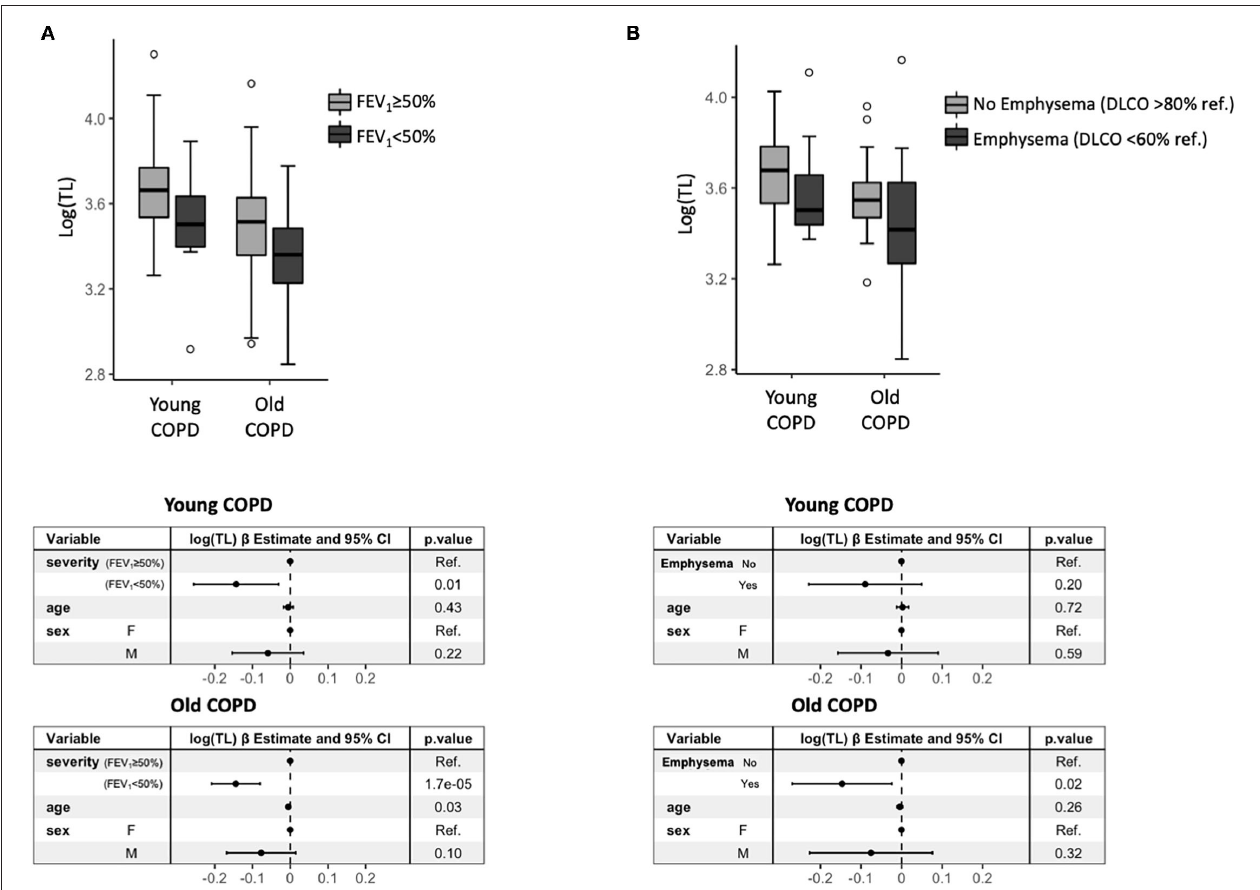
FIGURE 4 | (A) A box plot of log(TL) by severity of airflow limitation in the patients with COPD stratified by young ( n = 81) and old ( n = 159), and corresponding forest plots (bottom) of the linear regression model presenting the point estimates and 95% CI (whiskers) of the change in log(TL) when adjusted for the potential confounders. (B) A box plot of log(TL) according to the presence (DLCO % ref. < 60%) or absence (DLCO % ref. > 80%) of emphysema in the patients with COPD stratified by young ( n = 55) and old ( n = 78), and the corresponding forest plots (bottom) of the linear regression model presenting the point estimates and 95% CI (whiskers) of the change in log(TL) when adjusted for the potential confounders.